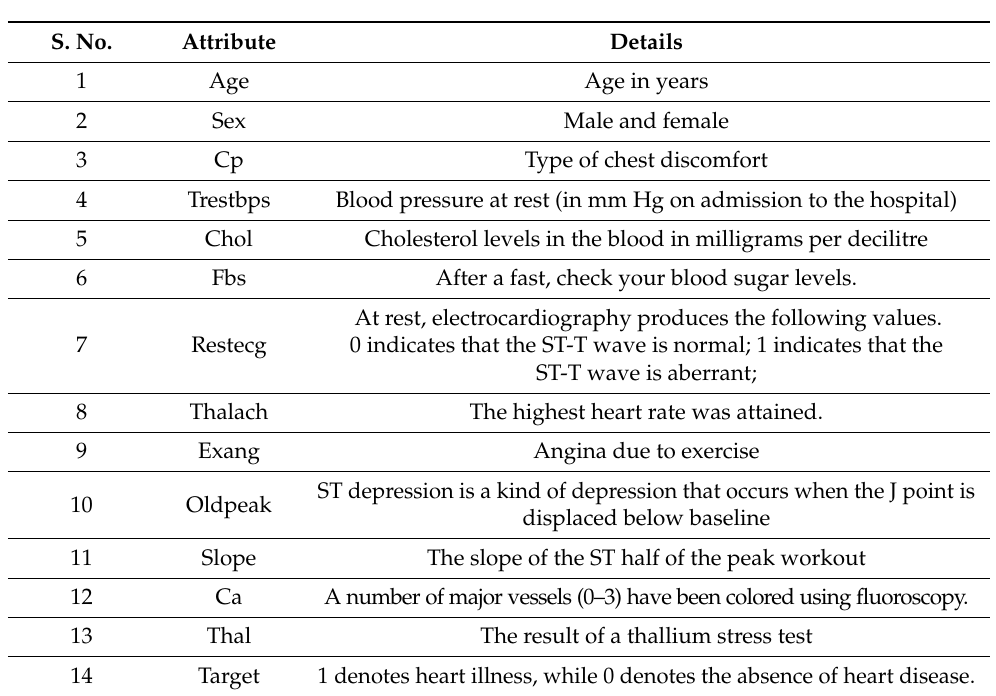
Table 1. Details of the